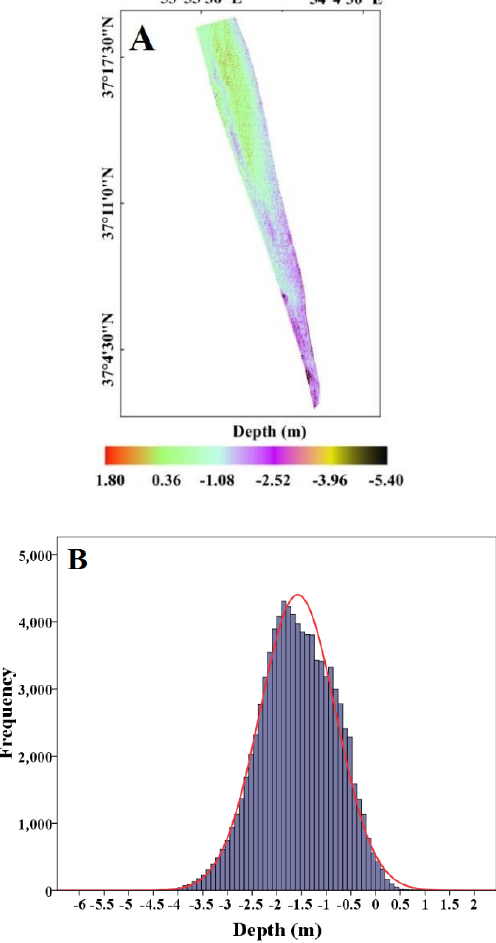
Figure 7. (A) Bathymetry Map of Gomishan Lagoon; (B) histogram of bathymetry